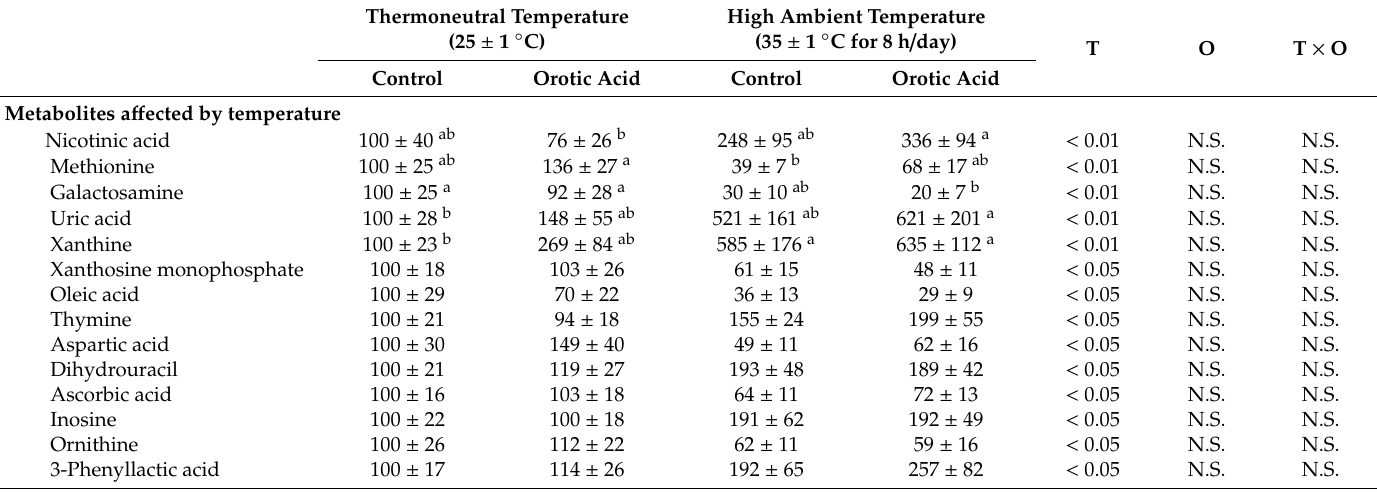
Table 4. E ff ects of a cyclic high ambient temperature and feeding orotic acid on plasma metabolites of broiler chickens. Thermoneutral Temperature (25 ± 1 ◦